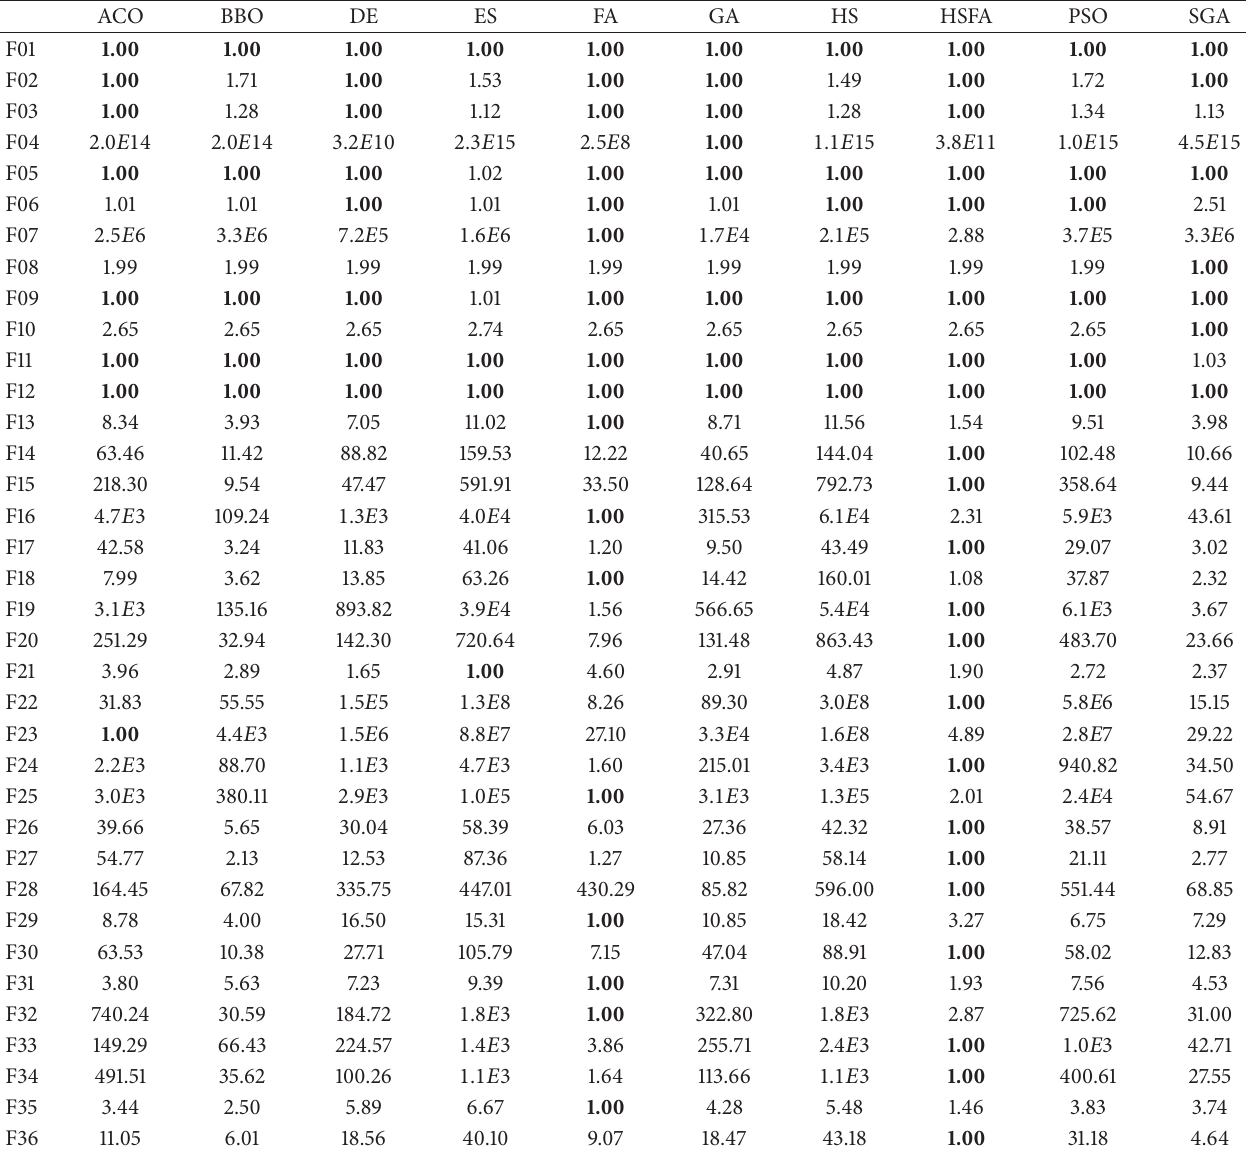
Table 3: Best normalized optimization